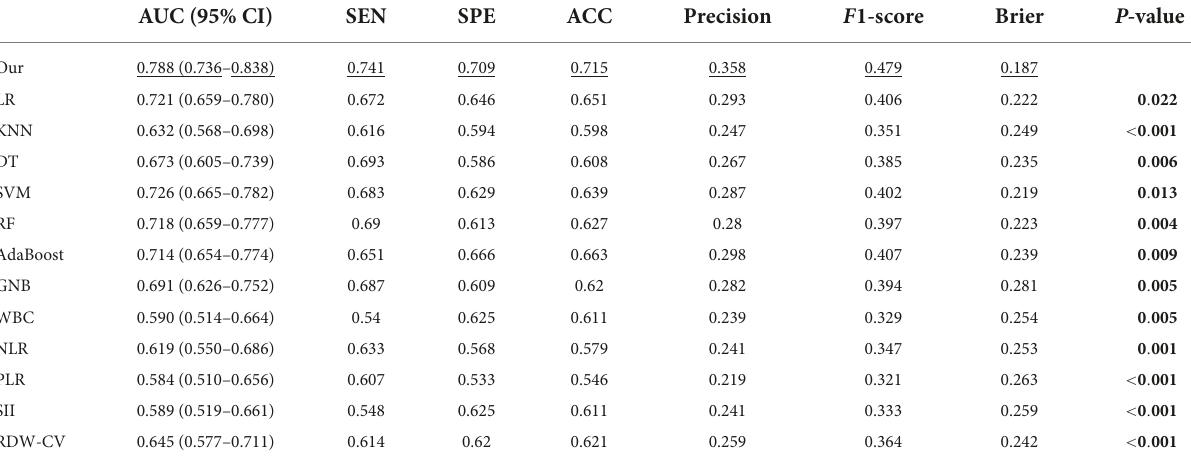
TABLE 4 Discrimination performance of all models and indices.